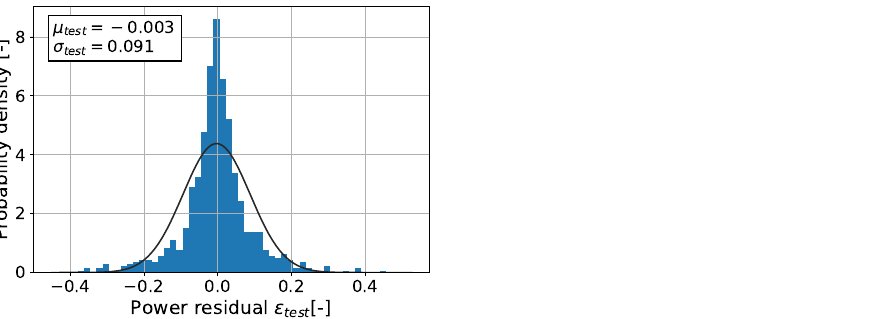
Figure 23. Probability density function of testing residuals including normal distribution fit for standalone SCADA model.